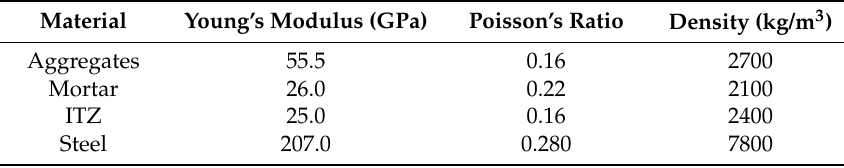
Table 1. Material parameters of meso-scale concrete core and steel tubular [29,30].